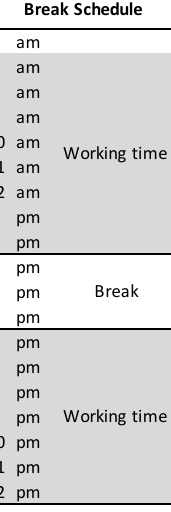
Figure 1. Work time organisations.